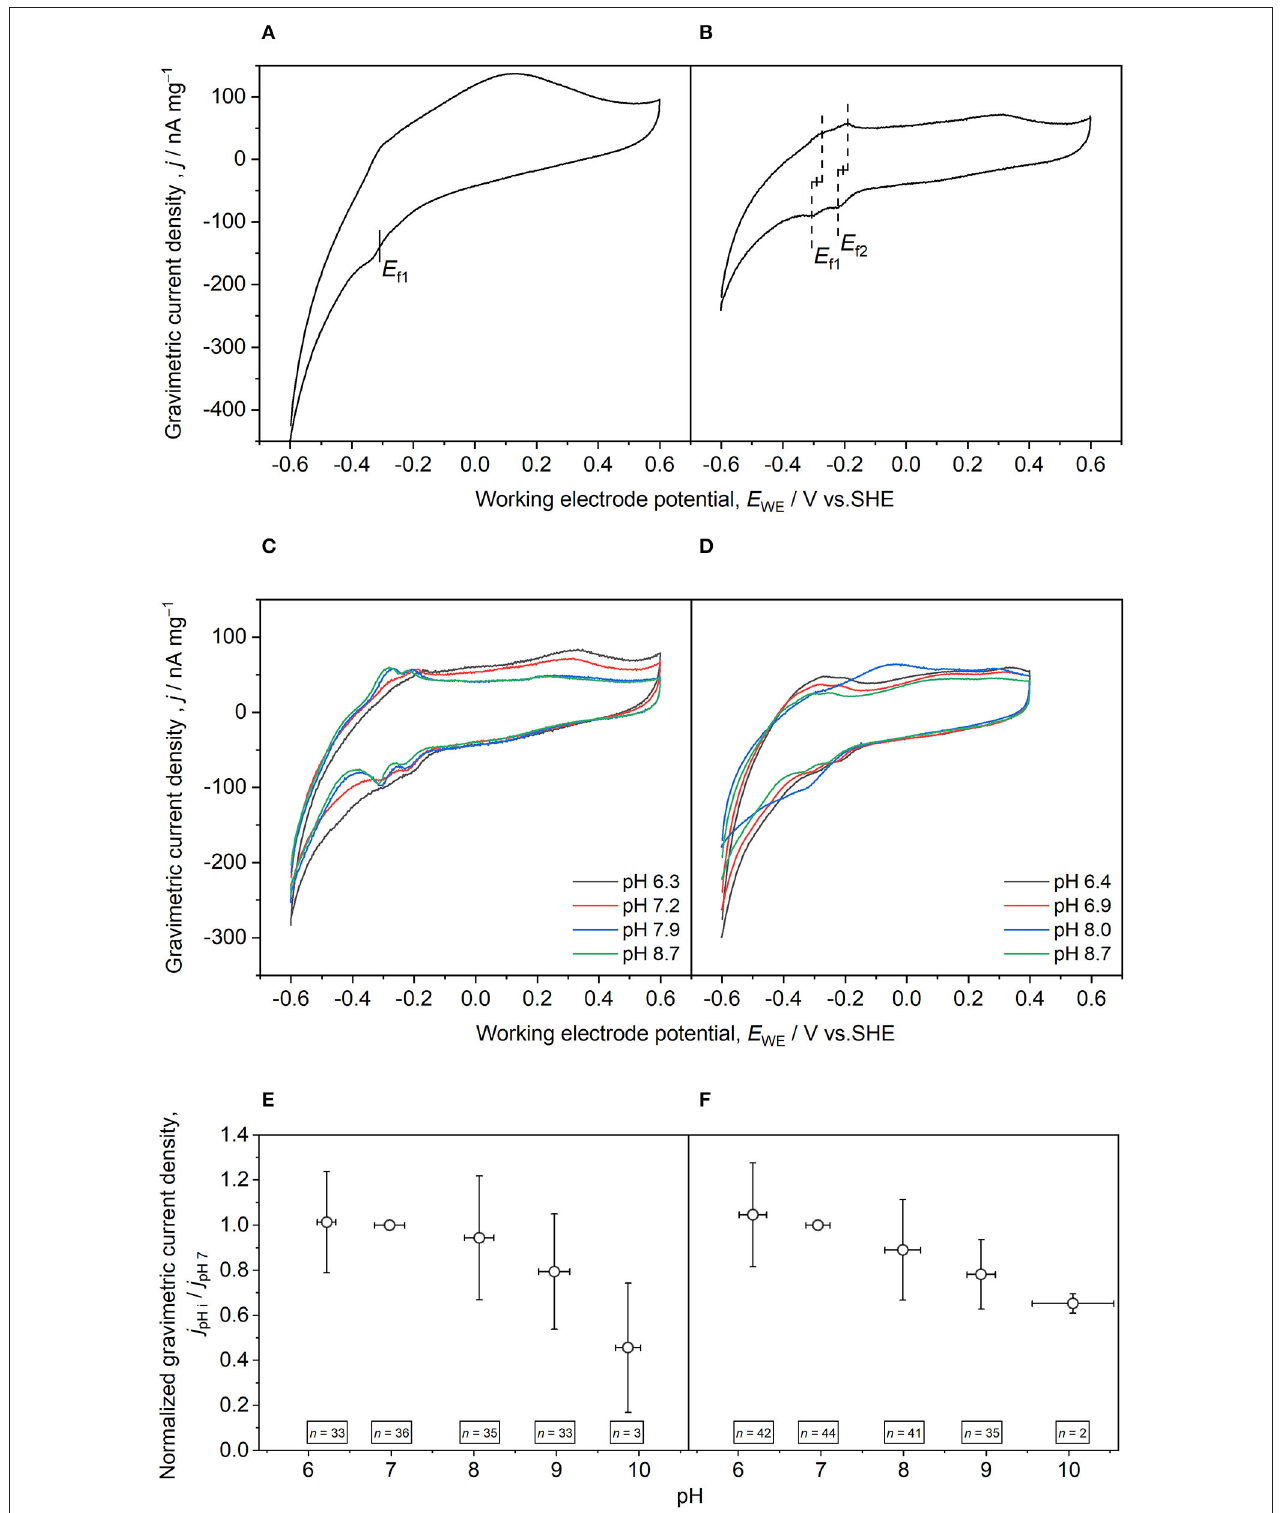
FIGURE 2 | Exemplary cyclic voltammograms recorded with granules sampled during the operational phase for determining formal potentials (A,B) and the bioelectrochemical response to different pH values (C–F) . (A) Reactor 1, 2nd sampling unit [more distant to current collector (CC)], day 247. The formal potential of the first redox site ( E f1 ) was determined by analyzing the respective inflection point. (B) Reactor 2, 1st sampling unit (close to CC), day 253. Formal potentials of the